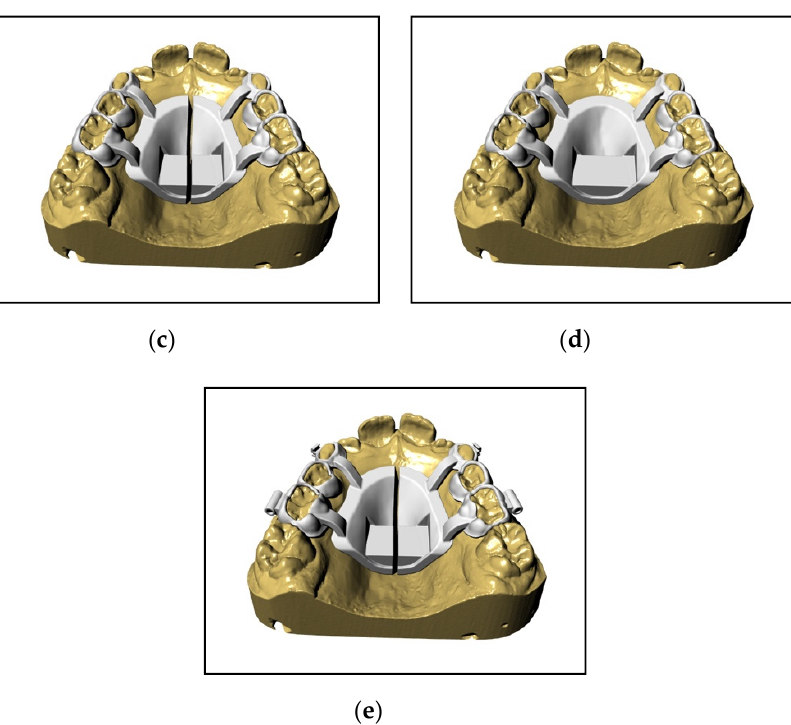
Figure 2. ( a ) Shield design. ( b ) Support structures built upon deciduous teeth. ( c ) Arms that connect the shield to the support structures. ( d ) Shield with support surfaces for the screw. ( e ) Final device complete with all accessories.